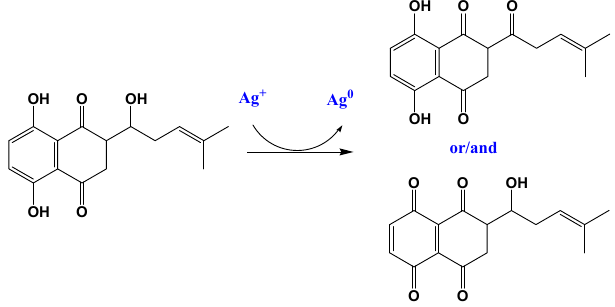
Fig. 5. The proposed mechanism for the synthesis of silver nanoparticles, due to the presence of shikonin and its